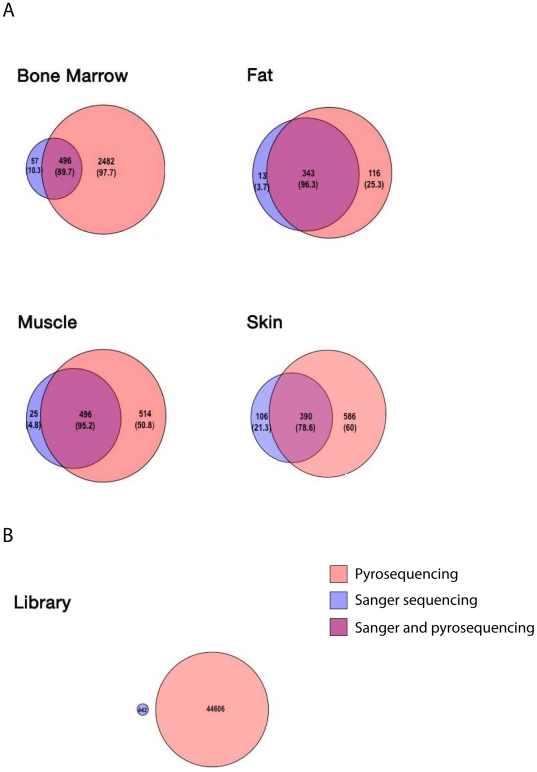
Overlap of sequences revealed by Sanger sequencing and next-generation pyrosequencing.Venn diagrams represent the peptides revealed by Sanger sequencing (purple) and large-scale next-generation pyrosequencing (salmon) in tissues such as bone marrow, fat, muscle, skin (A) or the non-selected CX7C library (B). The dark-pink area represents sequences found by both approaches. Numbers indicate the total peptides in each group and their percentage relative to TU-counting (purple and overlap areas) or relative to next-generation sequencing (salmon-colored area). No overlap was seen for the non-administered phage library sequences, produced by both methods. Circle sizes are proportional to the number of sequences revealed by each strategy.